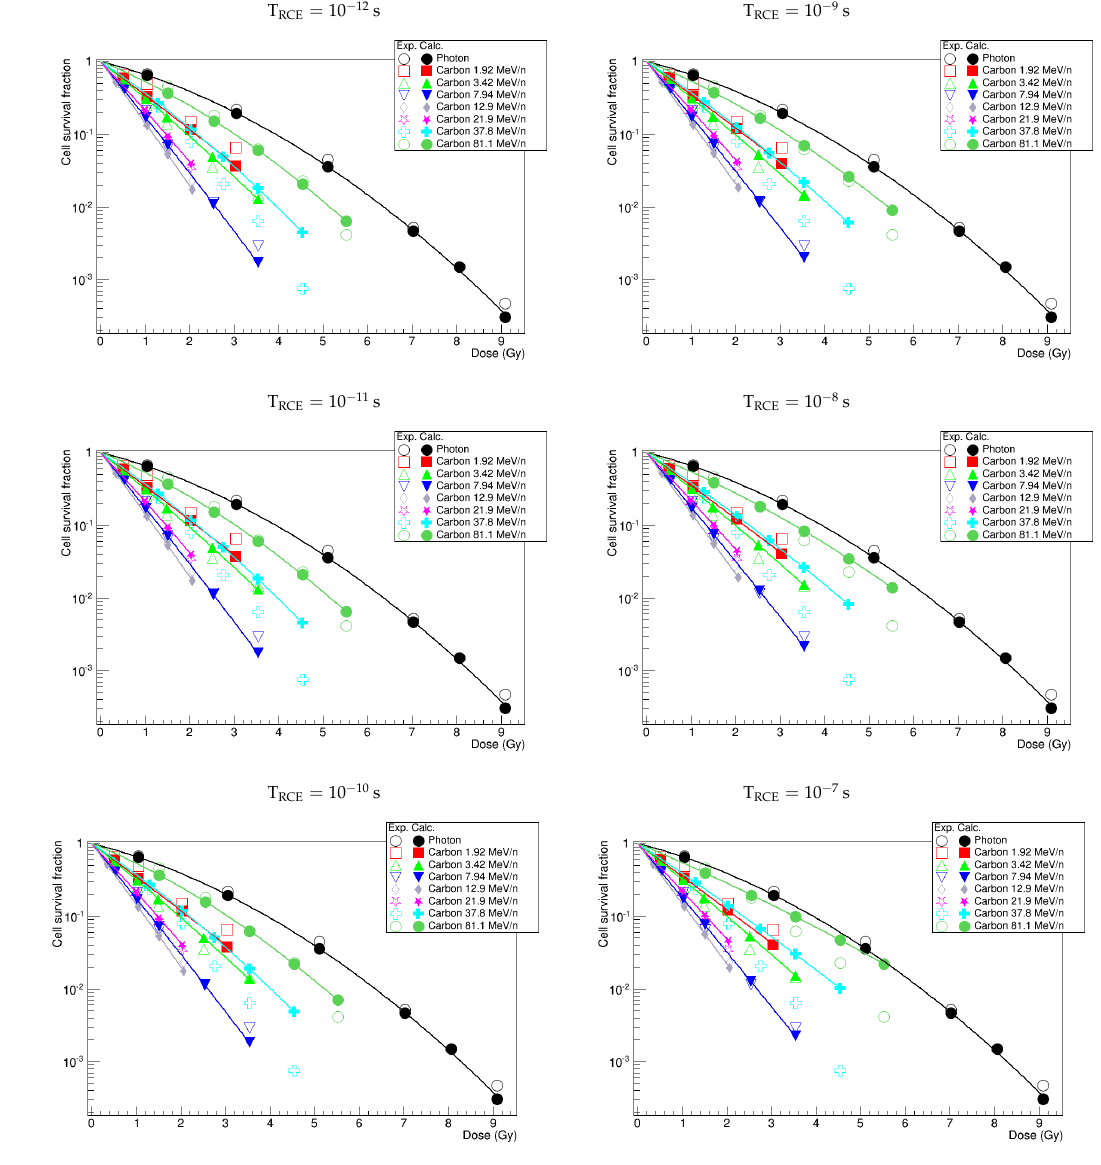
Figure 2. Calculated (Calc.) survival curves of HSG cells irradiated with photons and carbon ions compared to experimental data (Exp.) issued from [25]. In each graph, the probability of cell survival was calculated by assigning a different value to T RCE